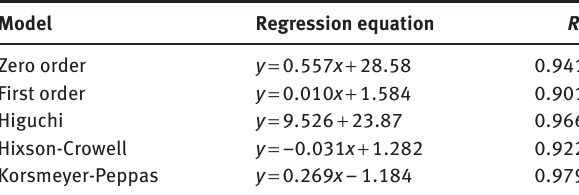
Table 3: Regression equations and the regression coefficient ( R 2 ) of Hq released from the PCHq20 nanoparticles in pH 7.4 solution according to different kinetic models.